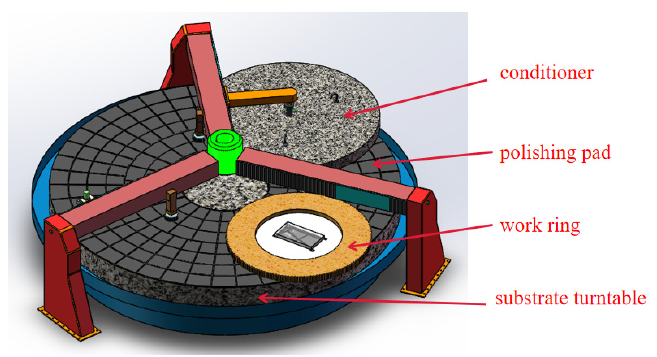
Figure 1. Continuous polishing machine.